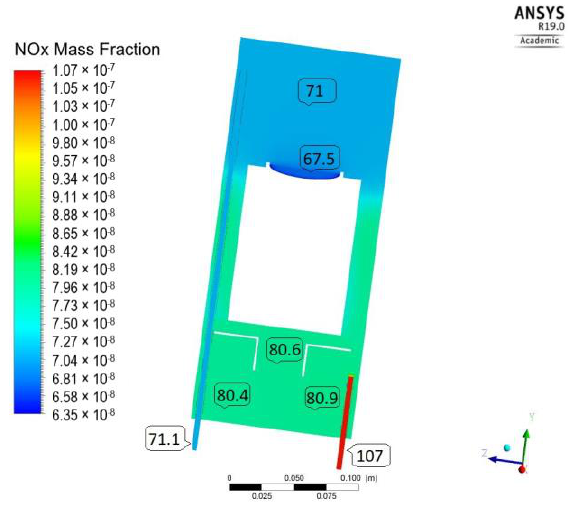
Figure 4. NO x concentration distribution (T300_GO /107ppb).